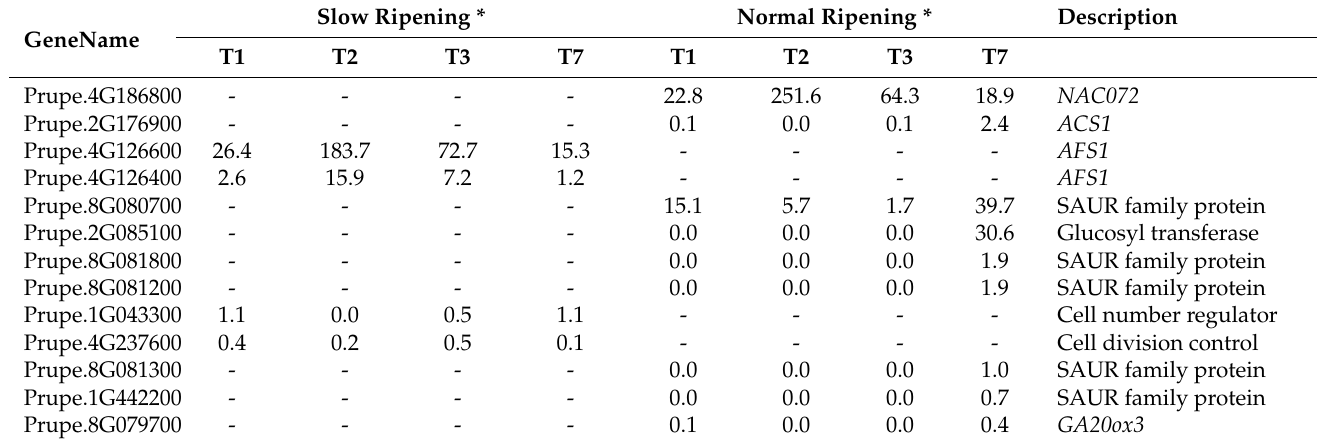
Table 1. NAC072 candidate genes related to gene expression